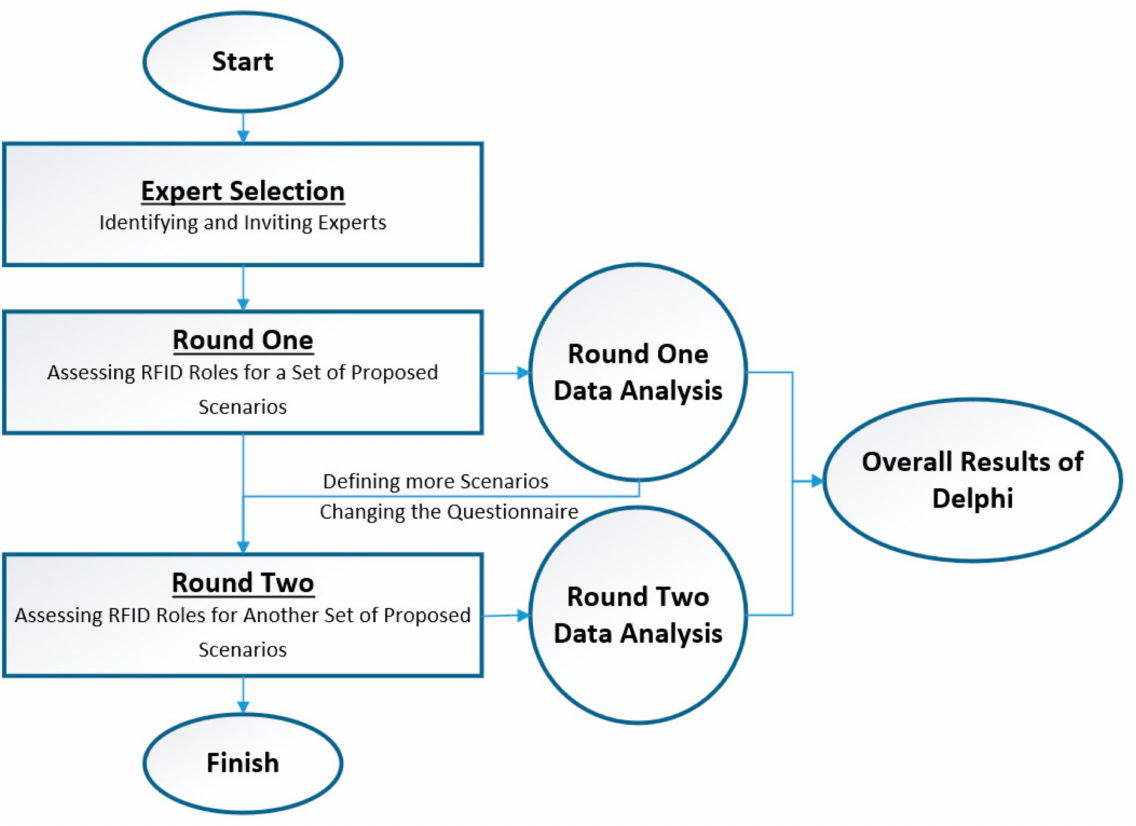
Figure 1. The overall structure of the Delphi